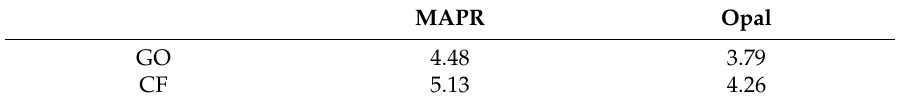
Table 8. CV (%) for peak swing flexion across IMU systems and knee angle algorithms. MAPR Opal GO 4.48 3.79 CF 5.13